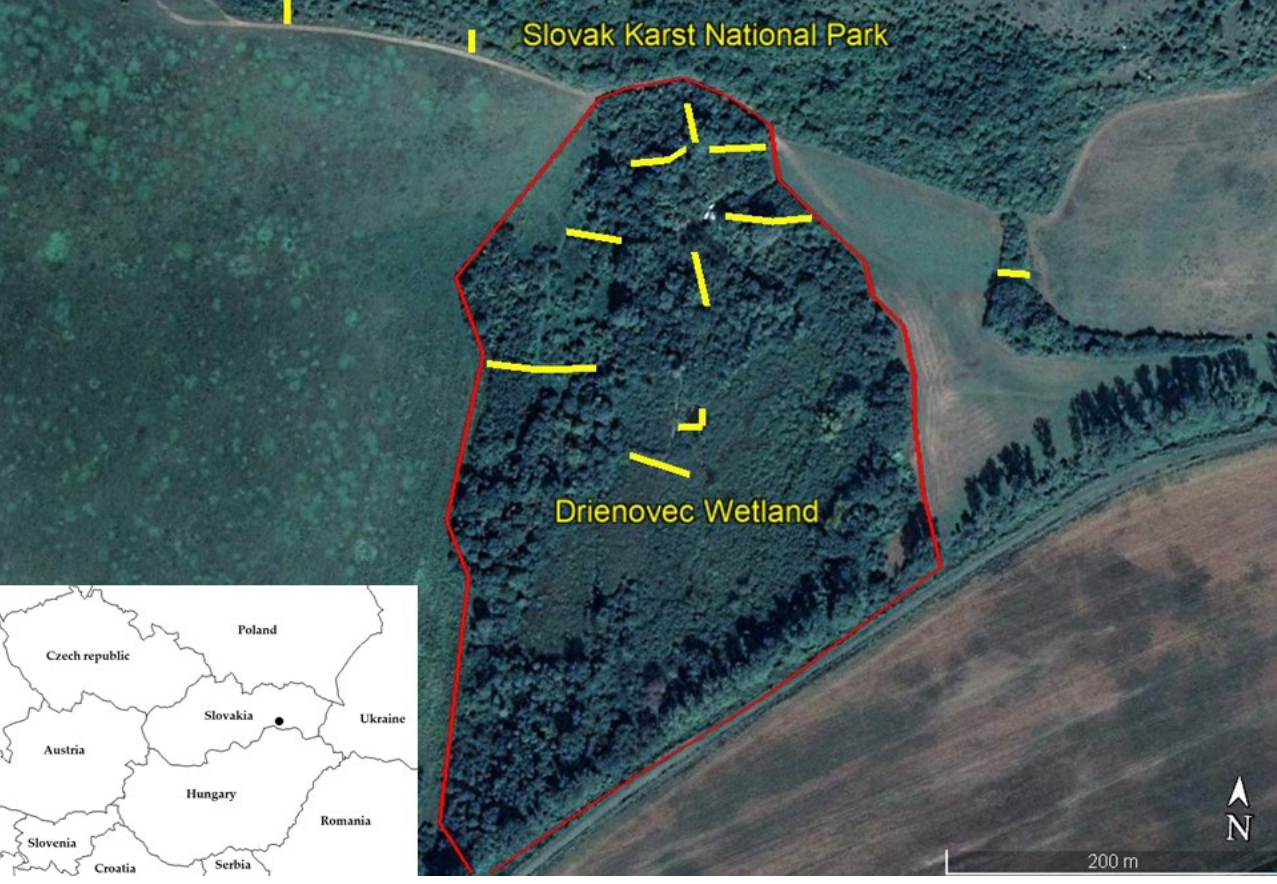
Figure 1. Location of Drienovská wetland and the distribution of mist nets. Legend Yellow lines depict the distribution of mist nets on the model area Drienovská wetland. Red lines depict the border of the model area. The insert in the left lower corner shows the location of Slovakia and its neighbouring countries in Central Europe.